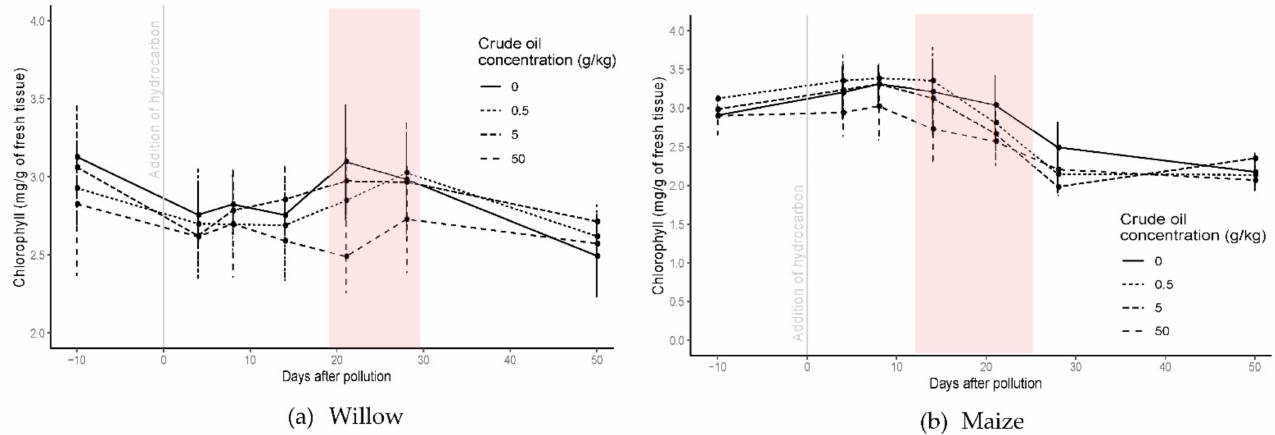
Figure 4. Chlorophyll content in willow ( a ) and maize ( b ) for all the crude oil treatments before and until 50 days the addition of the polluted layer. The red square highlights the period of significant differences between treatments. Bars represent the standard